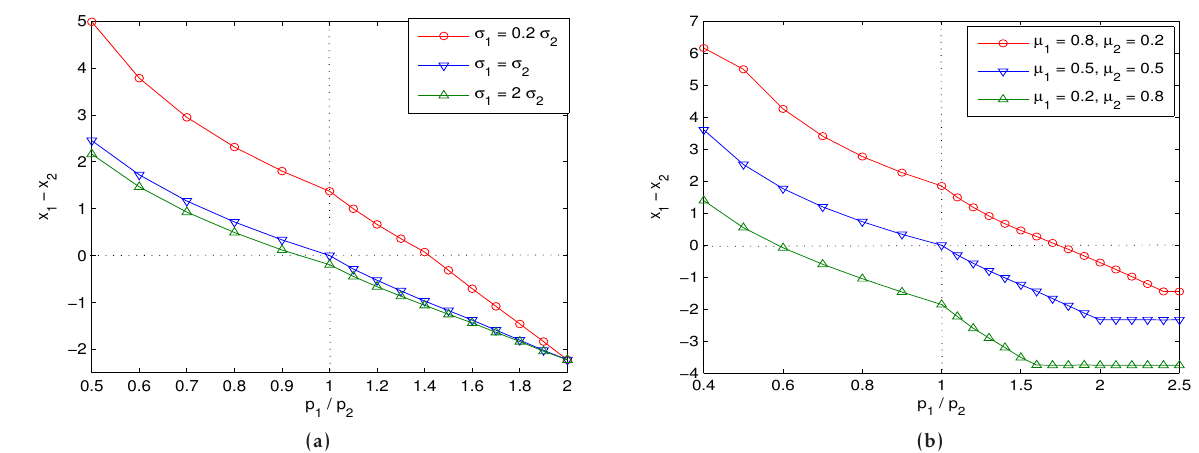
Figure 8. a) Relative contribution of the two secondary contract units as the ratio of the unit prices of the two secondary contracts is increased. Each curve corresponds to a fixed choice of the variance of B Each curve corresponds to a fixed choice of the mean of B